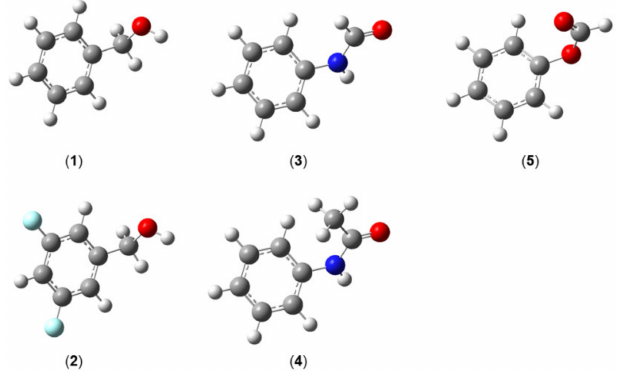
Figure 18. Molecules featuring an inversion-tunneling motion of the phenyl ring. ( 1 ) Benzyl alco- hol [206], ( 2 ) 3,5-difluorobenzyl alcohol [207], ( 3 ) E -phenylformamide [208], ( 4 ) cis -acetanilide [209], and ( 5 ) phenylformate [210].